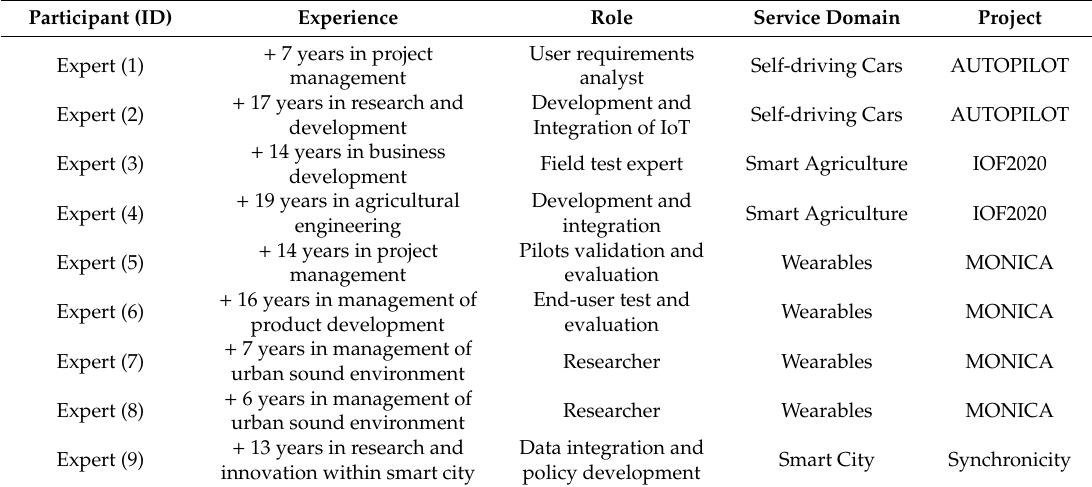
Table 4. Participants’ experience, role and workplace and project.